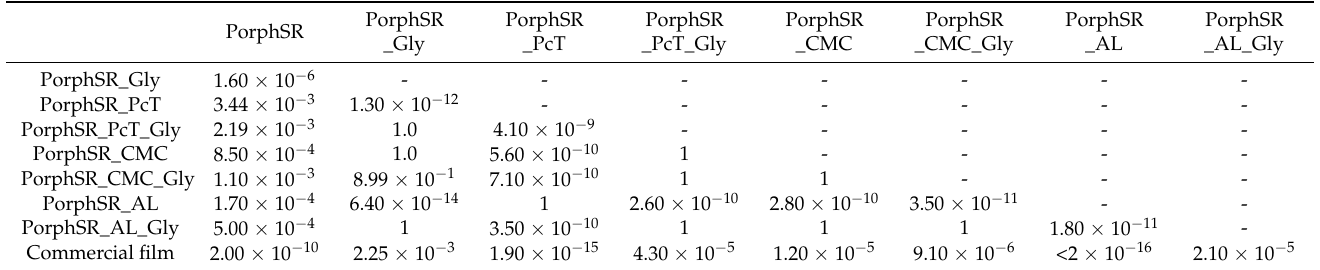
Table A5. Bonferroni pairwise comparison p -values for the different films’ apparent Young’s